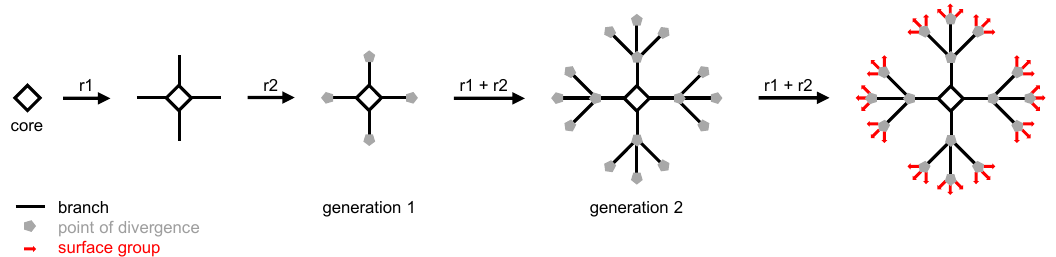
Figure 1. Schematic synthesis of a generation 2 (two series of branches) dendrimer using a tetravalent core (i.e., four branches in the first series) and trivalent points of divergence (i.e., 12 branches in the second series, and 36 surface groups). r1 and r2 are the reactions which are iterated to obtain the final dendrimer.